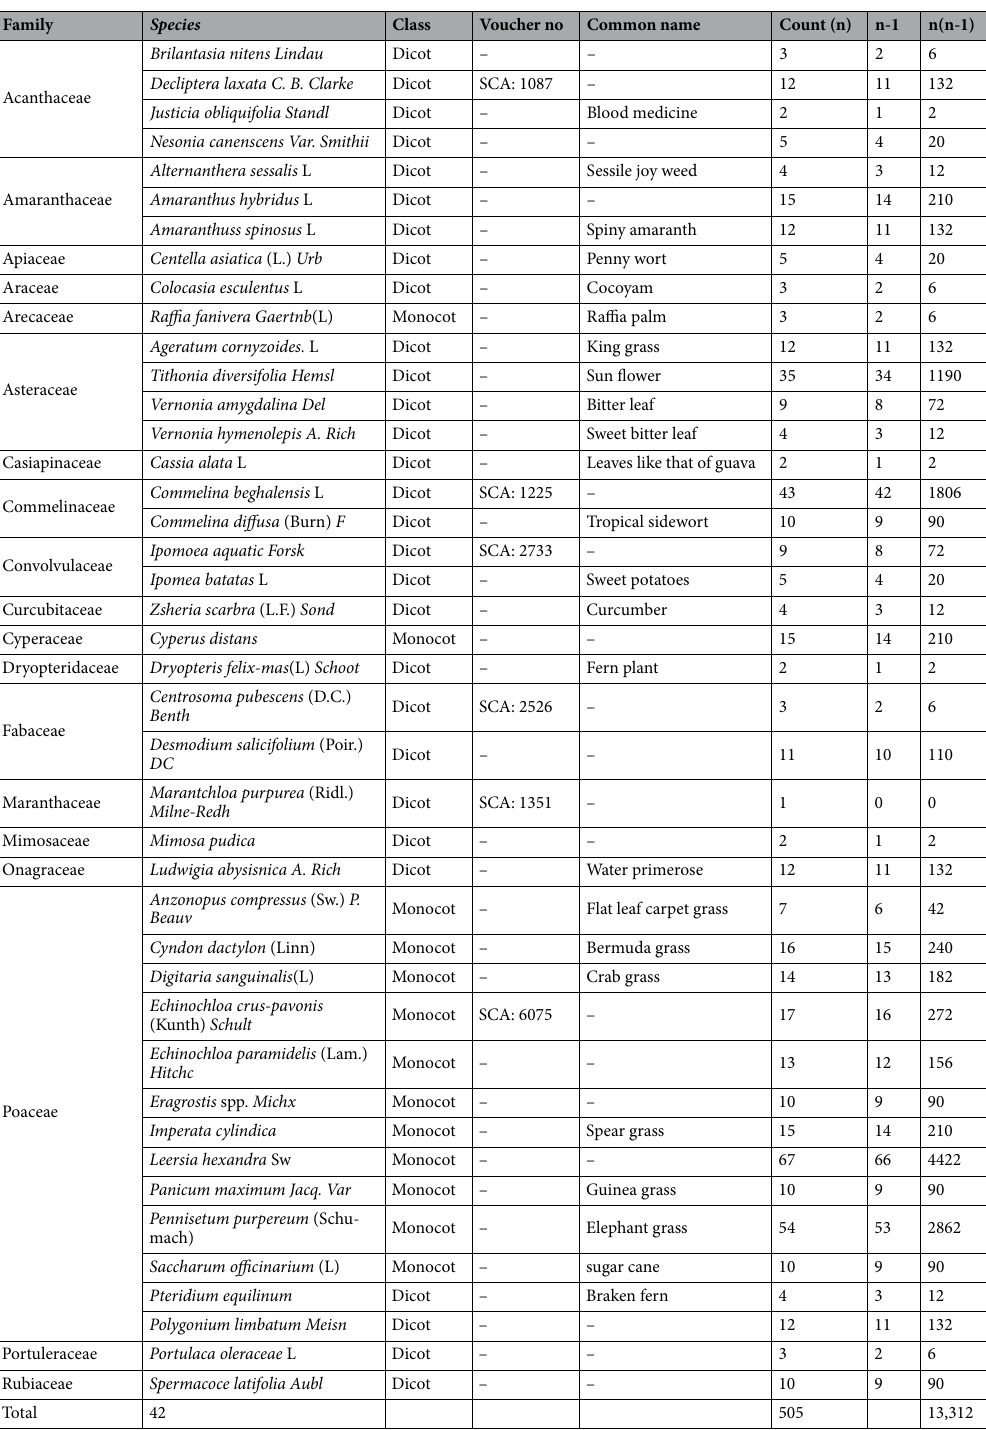
Table 3. Checklist of macrophytes diversity in the wetlands in Bamenda municipality, Cameroon. SCA Southern Cameroon (code for the Limbe Botanic Gaderns), D = 0.052302, Simpson index =